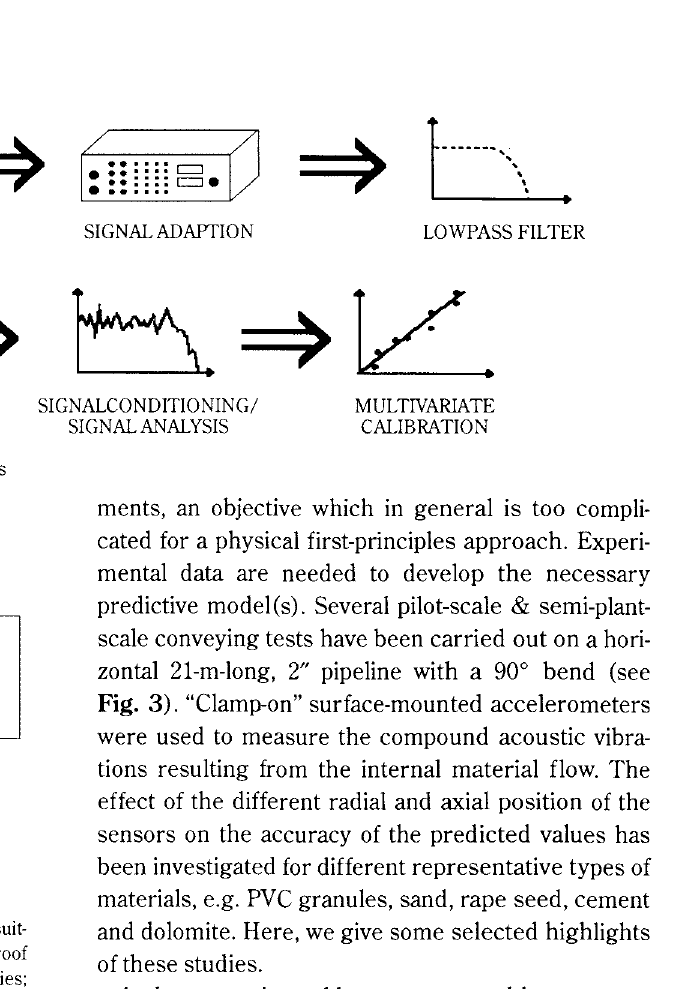
Generic data path flow-sheet in acoustic chemometrics